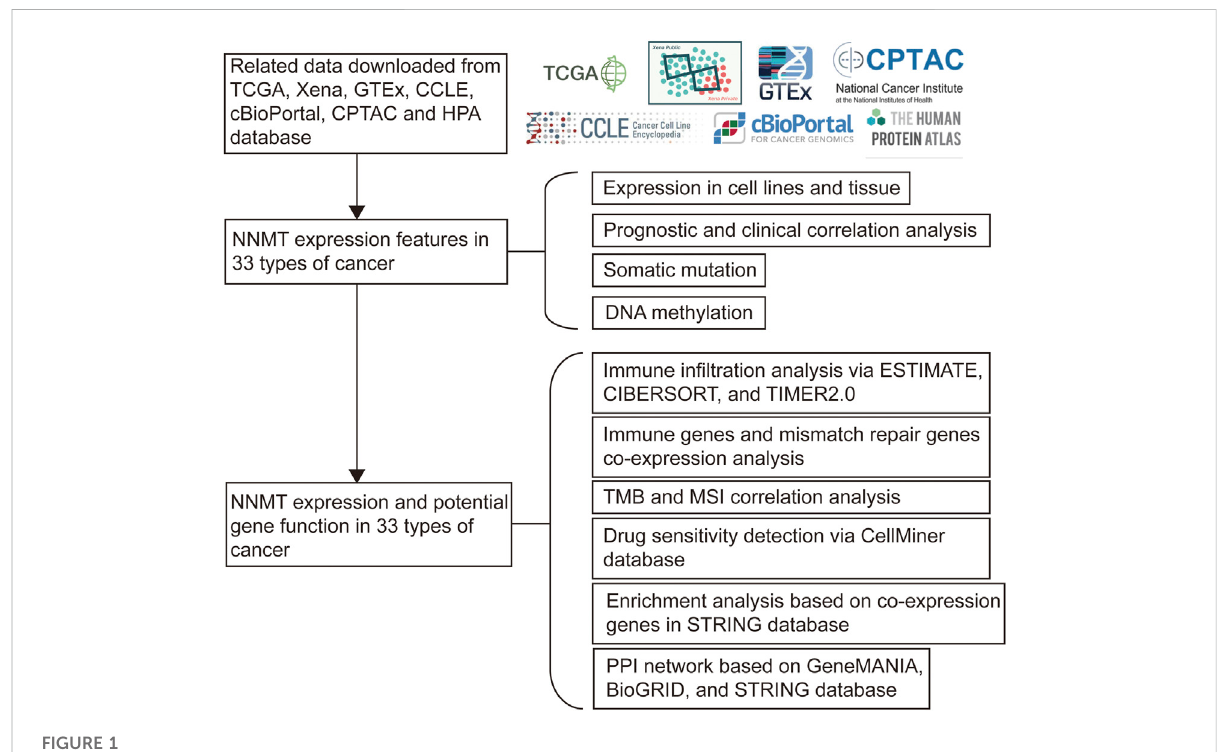
FIGURE 1 A fl ow chart of the